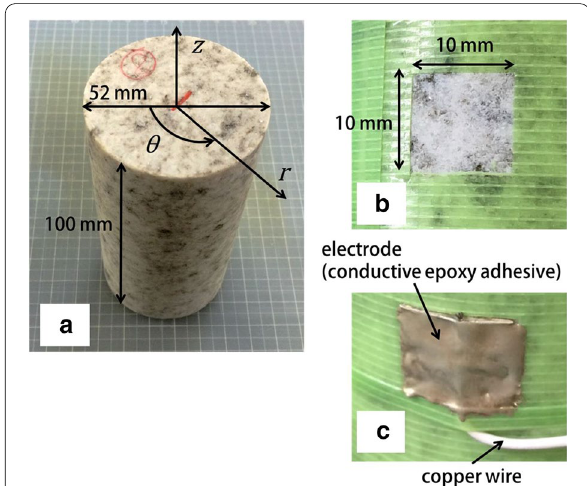
Fig. 2 Photographs of set-up for measurement of a granite sample. a The unpolished, cylindrical rock sample (52 mm diameter, 100 mm length) overlaid with the dimensions r , θ , and z defining its coordinate axis. b The electrode attachment area as controlled by insulating masking tape. c Conductive epoxy adhesive attached to the rock surface as a high-conductivity electrode